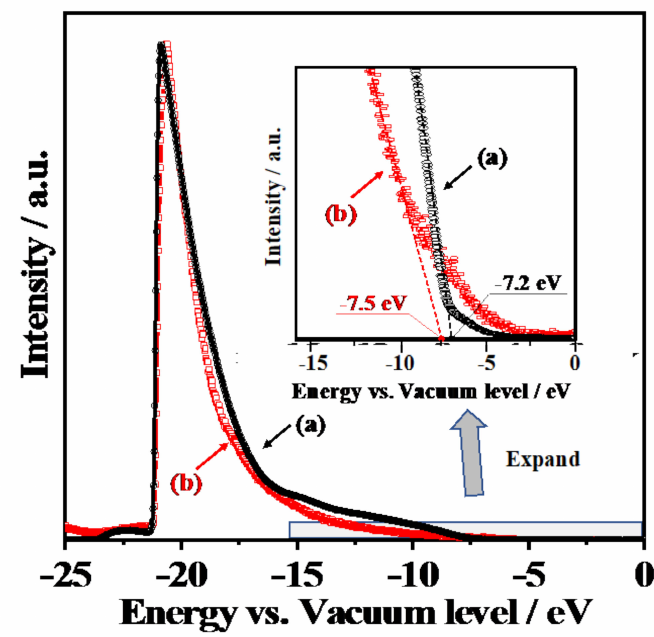
Figure 7. Ultra-violet photoelectron spectra (UPS) of 1573K-Pure-CeO 2 ( a ) and 1573K-CPT-30.0YDC ( b